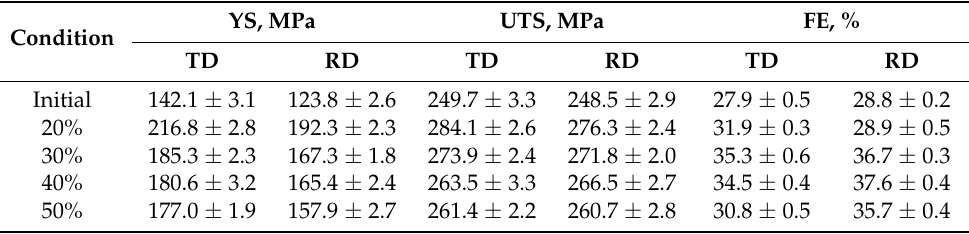
Table 2. Summarized mechanical properties of AZ31 magnesium alloy sheets rolled at 400 ◦ C (YS: yield stress; UTS: ultimate tension stress; FE: fracture